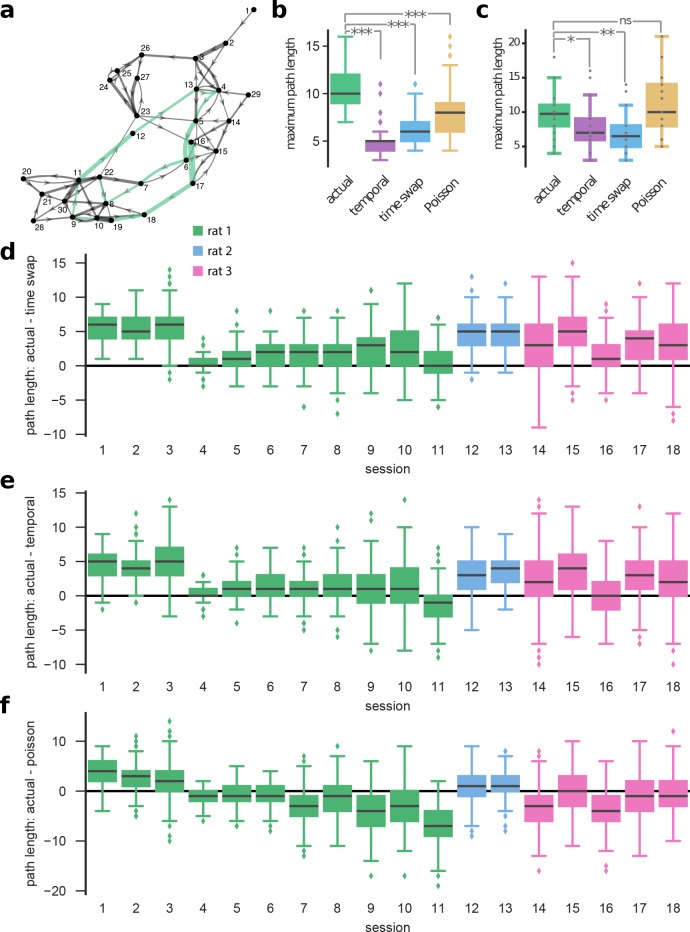
The sparse transitions integrate into long sequences through the state space.We calculated the longest path within an unweighted directed graph corresponding to the transition matrices of HMMs, with nodes representing states and edges reflecting the transition probabilities (see Materials and methods). (a) The graph—displayed using the ‘force-directed layout’ (Fruchterman and Reingold, 1991)—represents a model trained on actual data. For illustration purposes, we ignored transition probabilities below 0.1. The green path shows the longest path in the example. (b) For this example session, we computed the maximum path length (the number of nodes in the longest path) for actual and corresponding shuffle datasets (temporal, time-swap, and Poisson) (n=250initializations/shuffles). (c) The panel shows aggregate results built of median maximum path lengths from all sessions. We find that the actual data results in longer paths compared to time-swap (p=0.008, Mann–Whitney U test) and temporal surrogate datasets (p=0.04, Mann–Whitney U test). On the contrary, no significant difference is found in comparison with the Poisson datasets (p=0.57, Mann–Whitney U test). Nevertheless, due to non-sparseness of the observation matrix for a Poisson model (Figure 2—figure supplement 3), in most instances these paths correspond to highly overlapping ensemble sequences. In panels (d–f), difference between maximum path lengths obtained from actual data and surrogate datasets are shown separately for all sessions: actual versus (d) time-swap, (e) temporal, and (f) Poisson. The data results in longer paths compared to time-swap and temporal shuffle datasets in most sessions (15 out of 18) (p<0.001, Mann–Whitney U test), though in only five sessions compared to Poisson surrogate datasets.